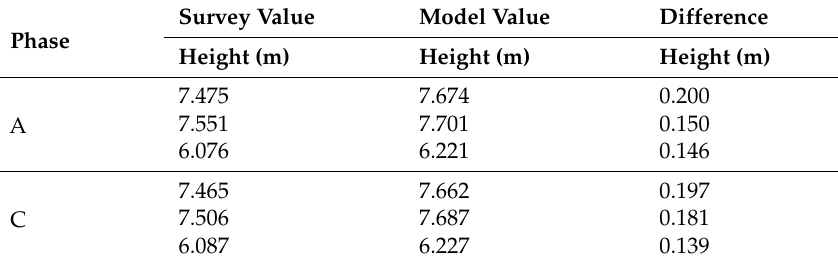
Table 10. Comparison of relative model accuracy of power